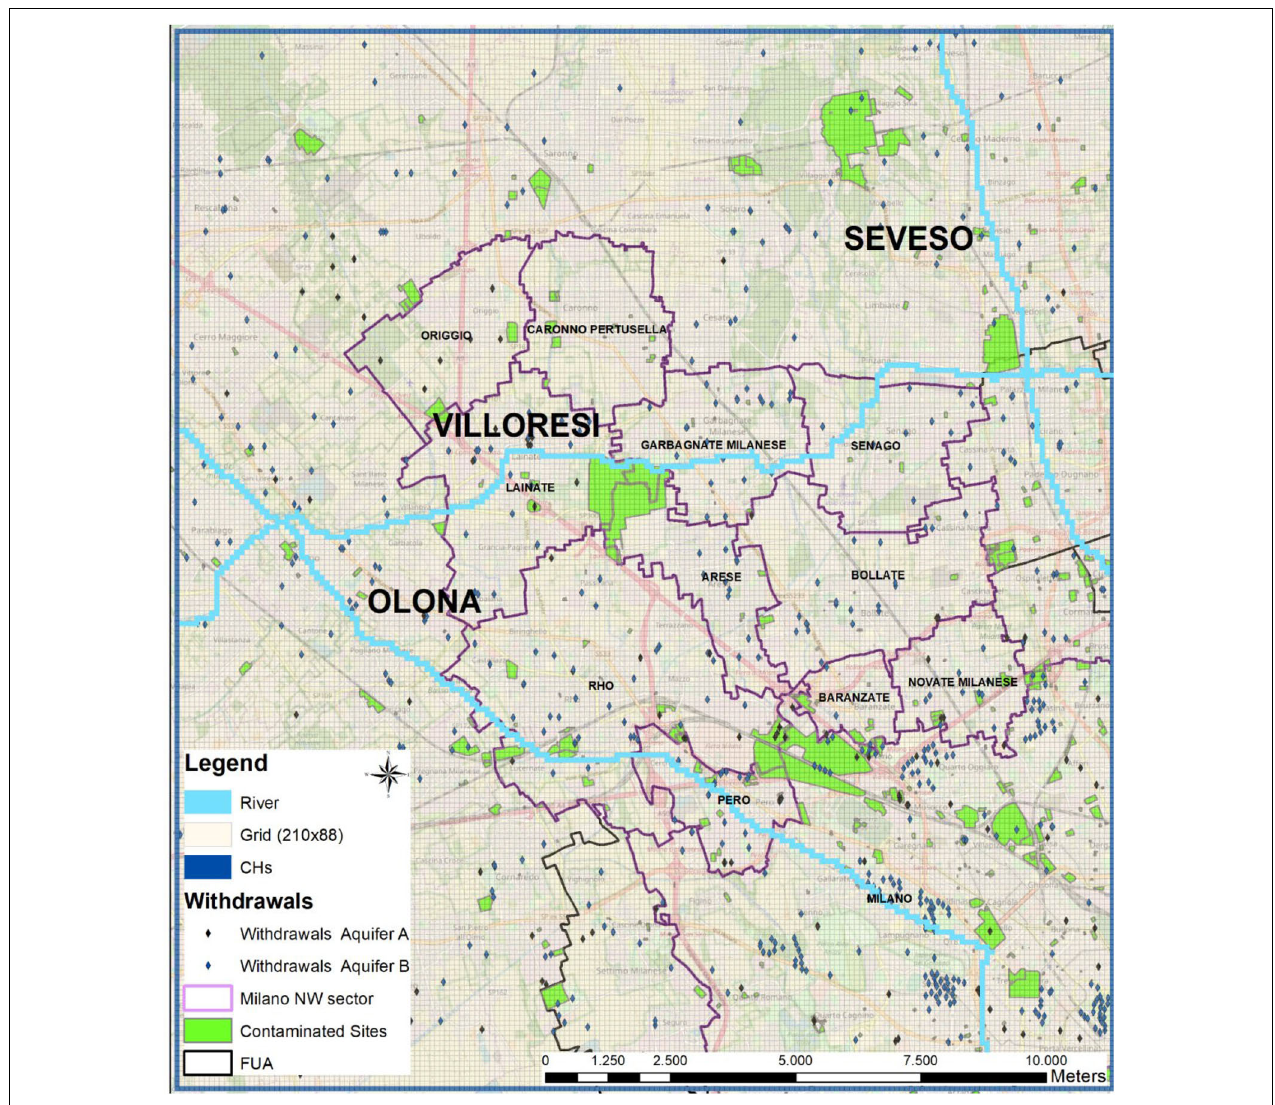
FIGURE 2 | Model domain, internal conditions (rivers in light blue), and wells (divided in the two aquifers based on the screens position). For more details about the model implementation, see Supplementary Figure S1 (Colombo et al., 2019).